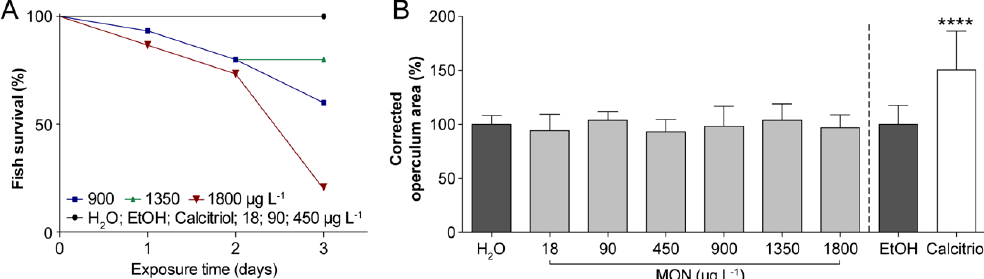
Figure 1. ( A ) Zebrafish larvae survival throughout three days of exposure to different concentrations of moniliformin (MON) starting at three days post-fertilization (dpf); Black line with circles includes the values for controls (H 2 O, EtOH and calcitriol) and for MON at 18, 90 and 450 ug L − 1 ; ( B ) Osteogenic effect of different concentrations of MON assessed in developing zebrafish larvae through alizarin red S staining of the operculum. Changes in operculum area are expressed as percentages over the respective control i.e., H 2 O for MON and EtOH (0.1%) for calcitriol (10 pg mL −1 ). Corrected operculum area was determined by normalization with the area of the head according to Tarasco et al. [21]. Asterisks indicate values statistically different according to Student’s t test (**** p < 0.0001). Data presented as average ± standard deviation (SD) of average.